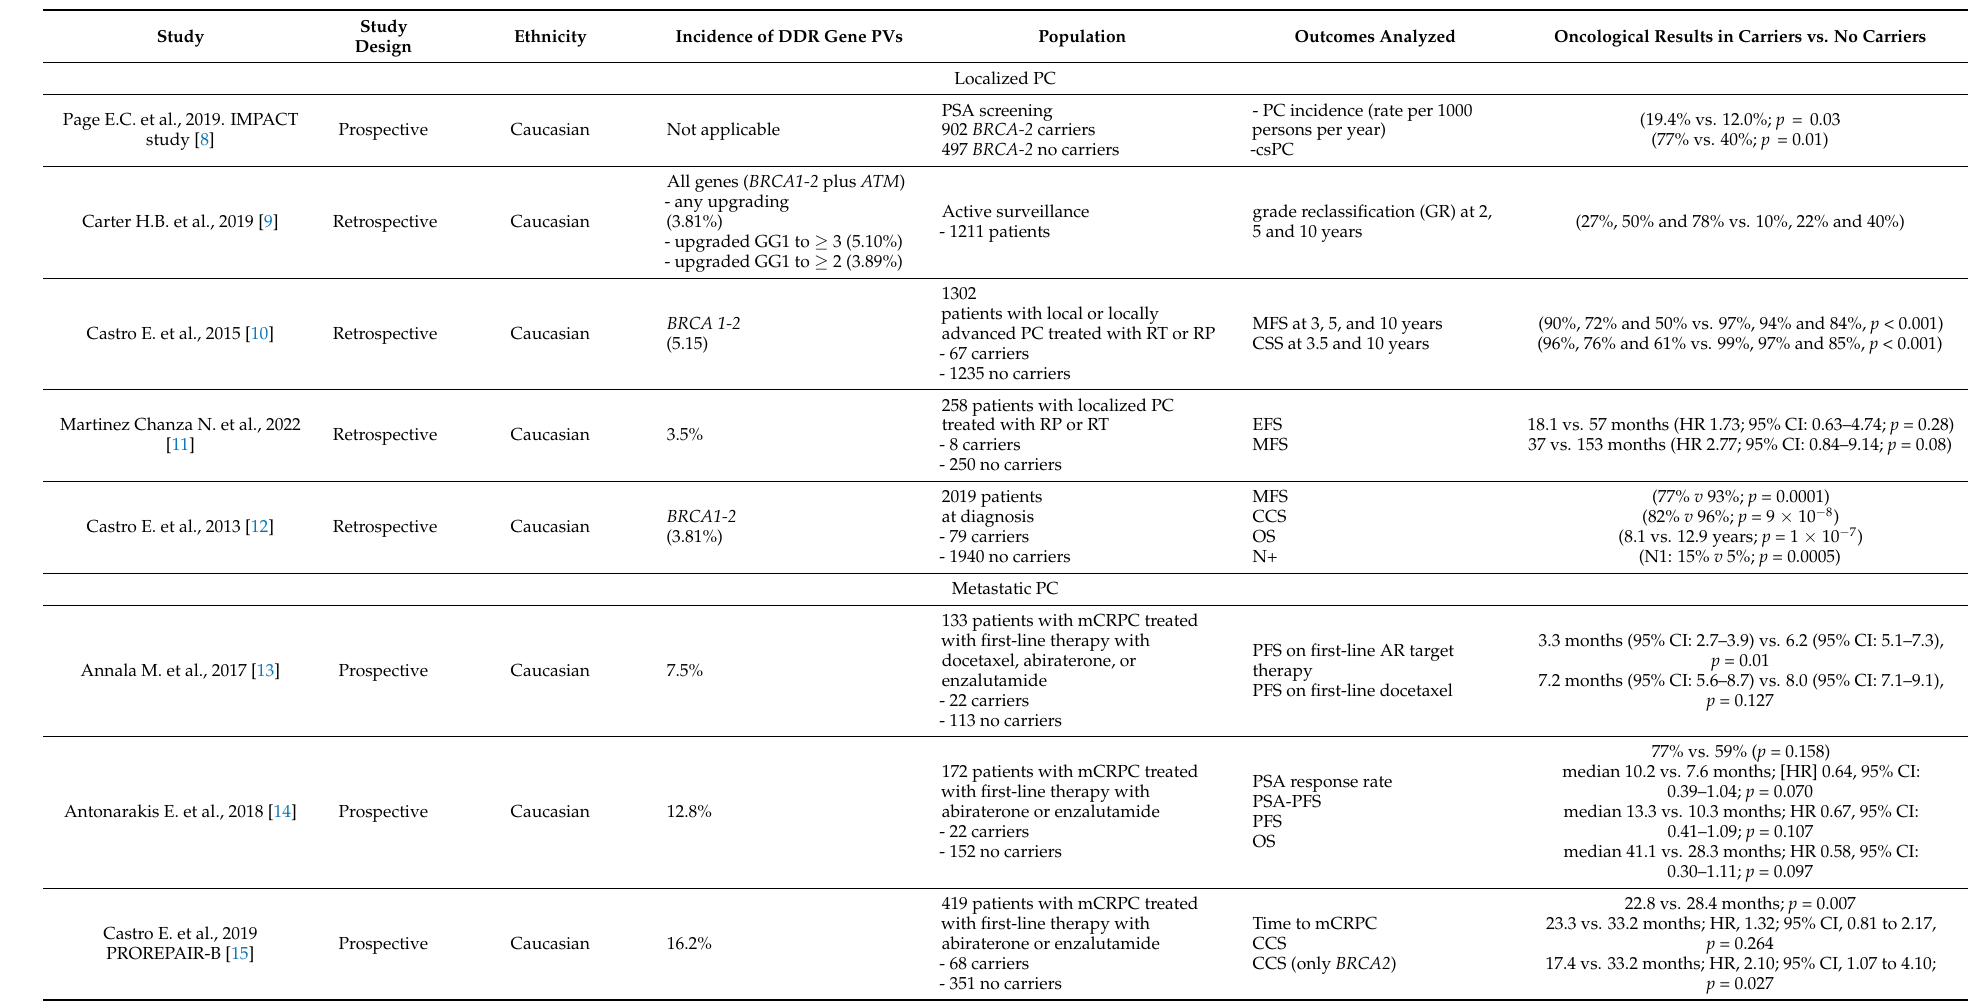
Table 1. Studies reporting the outcomes on the prognostic role of DDR PVs in localized PC and mPC (csPC, clinical significant prostate cancer; MFS,